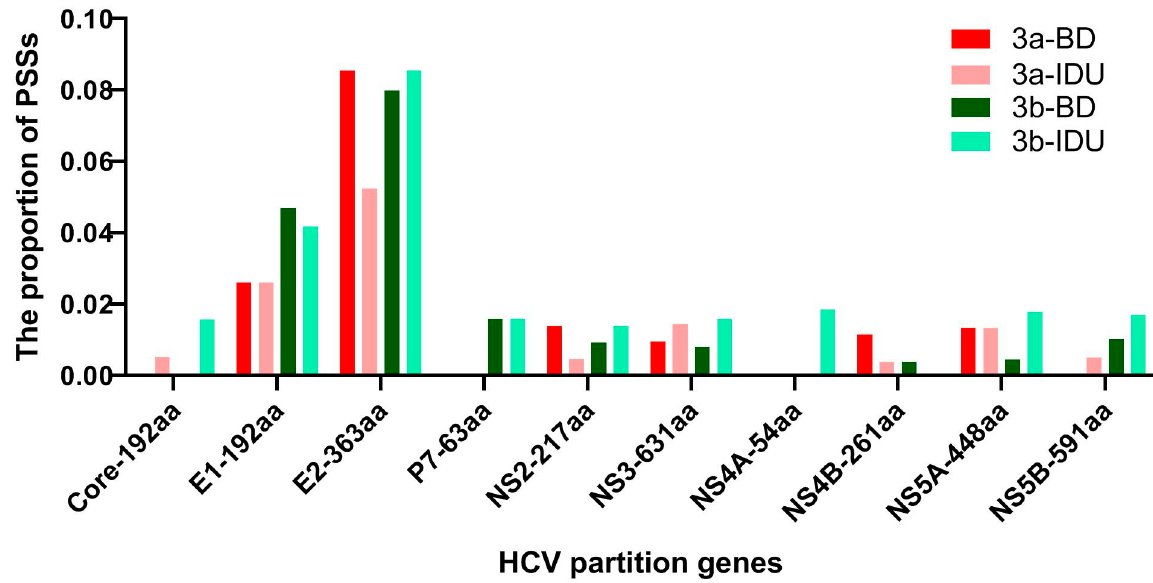
Figure 5. The distribution of PSSs in the polyprotein of the H77 reference sequence for HCV GT-3a-